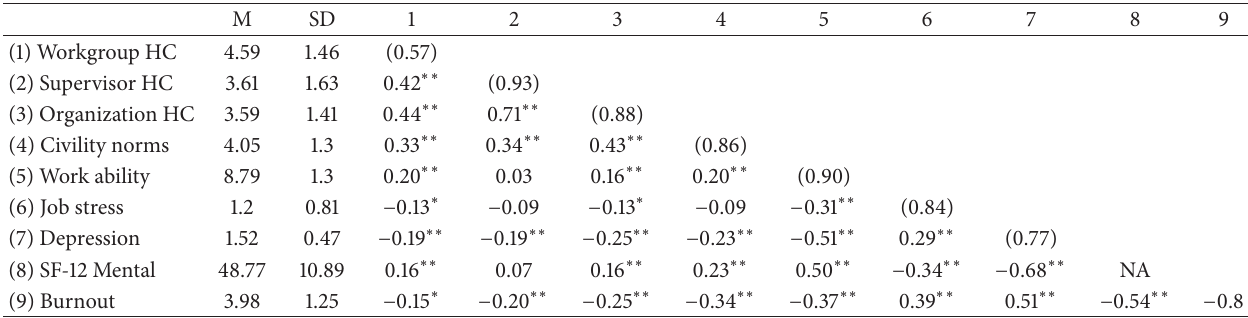
Table 1: Sample 1 correlation